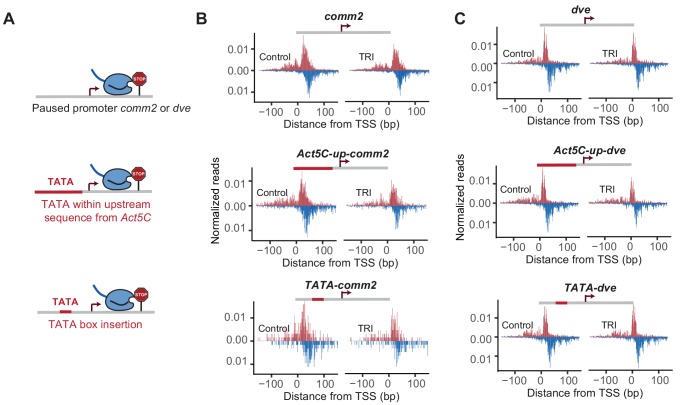
Effect of TATA insertion at comm2 and dve.Pol II ChIP-nexus profile at comm2, Act5C-up-comm2, TATA-comm2, dve, Act5C-up-dve and TATA-dve promoters under control condition and after Triptolide (TRI) treatment (40 min for comm2 and 1 hr for dve).